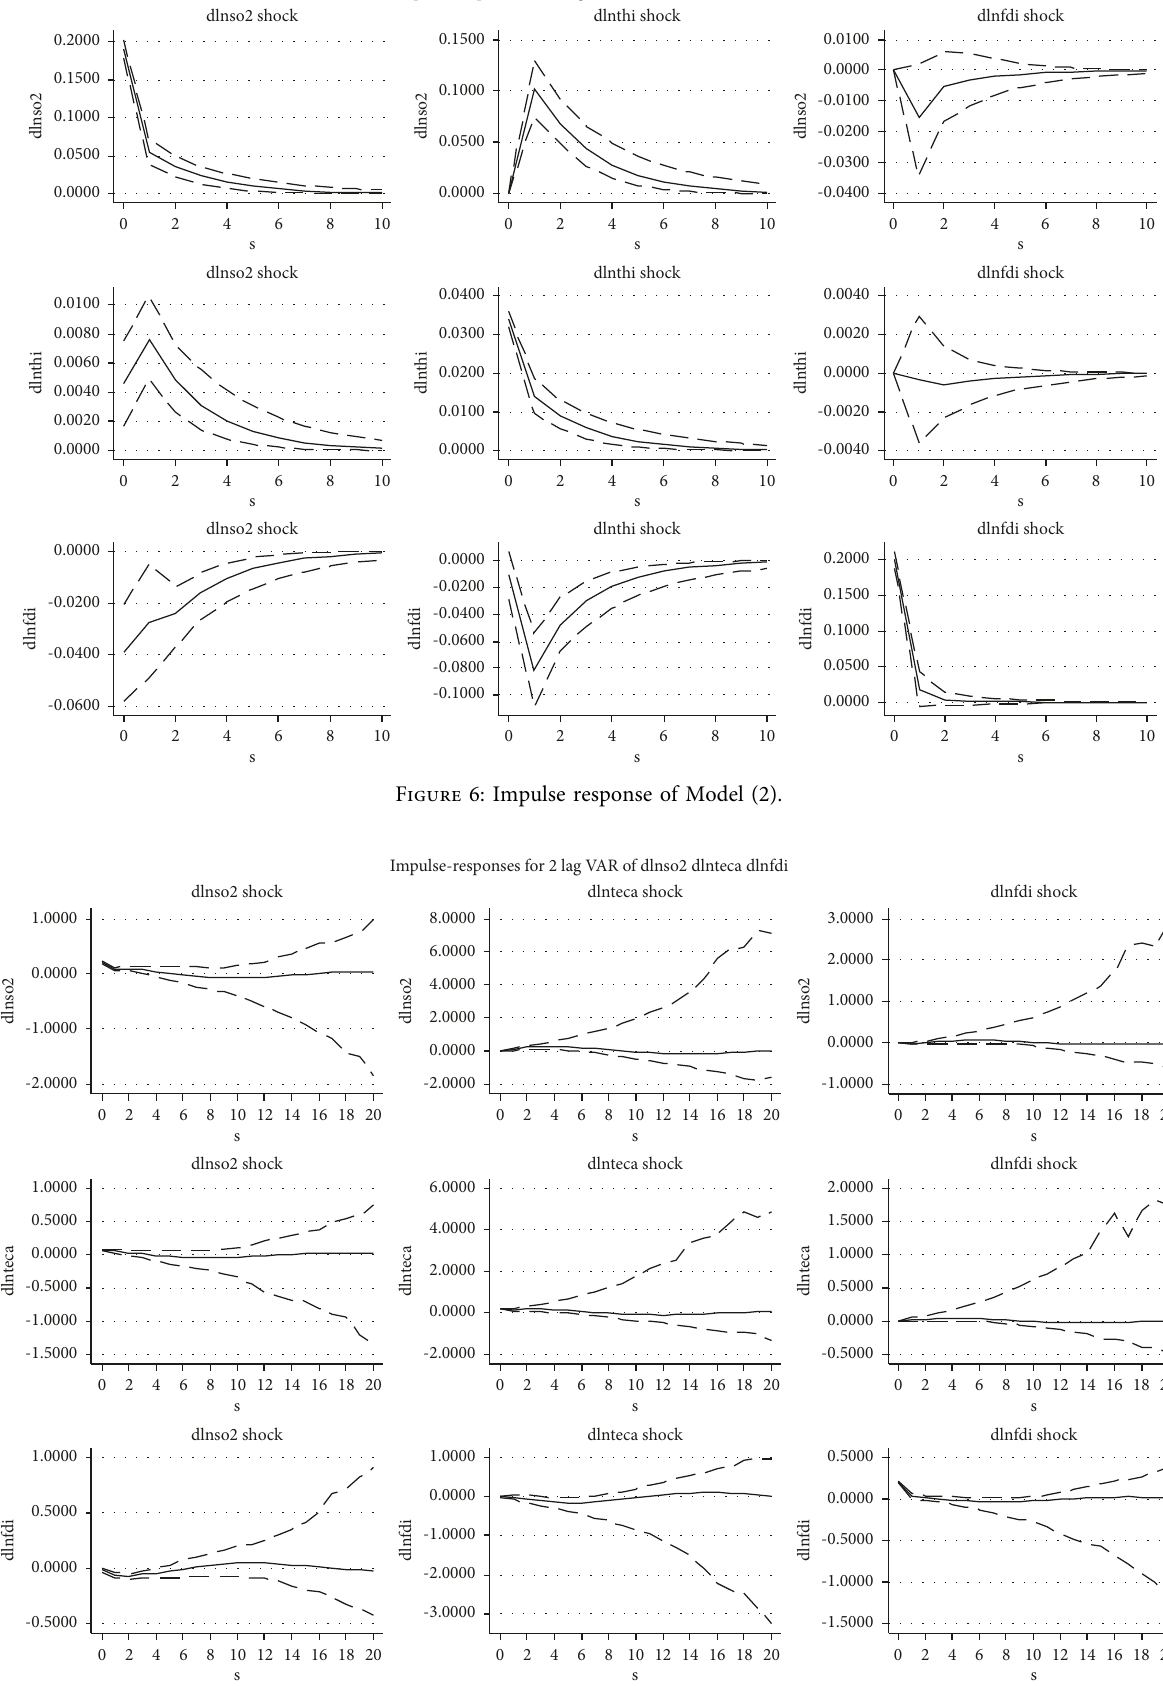
Figure 7: Impulse response of Model (3).